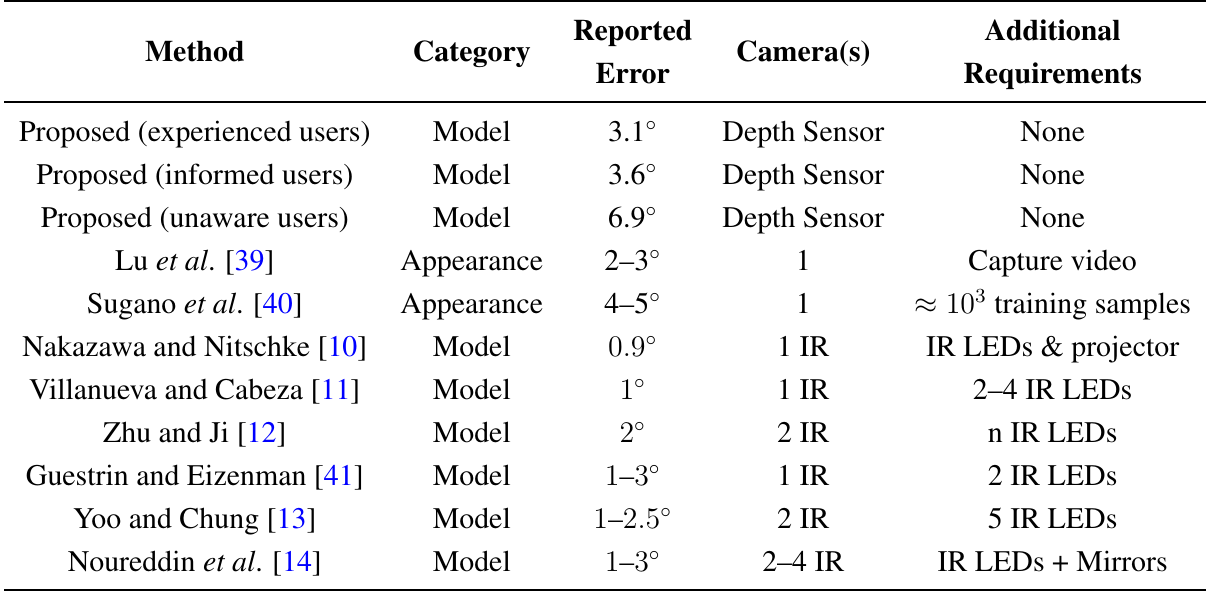
Table 4. Head motion ranges (in world coordinate system) used in the final